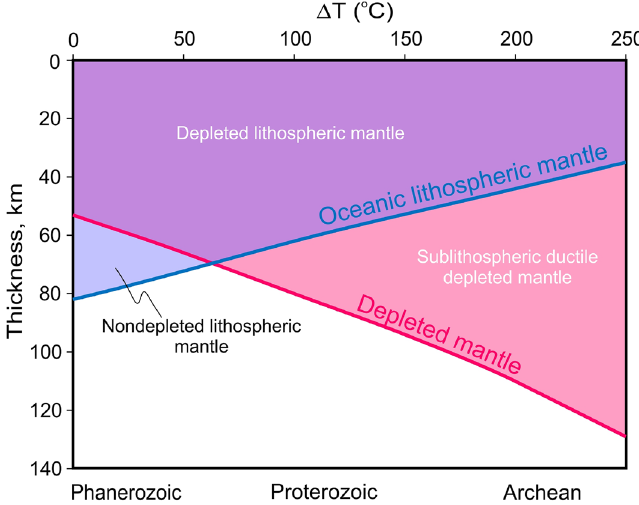
Figure 1. Divergent thicknesses of the lithosphere and depleted mantle (restites) at different potential mantle temperatures (T p ). Note the considerable protrusion of the depleted mantle through the lithosphere in Archean time (at ΔT > 1500 °C) and hidden within the lithosphere in the modern Earth. Thicknesses of the lithosphere and depleted mantle were taken directly from the output file related to the very initial stage of the modeling and correspond to isotherm 1300 °C and 20% of mantle melt-depletion,